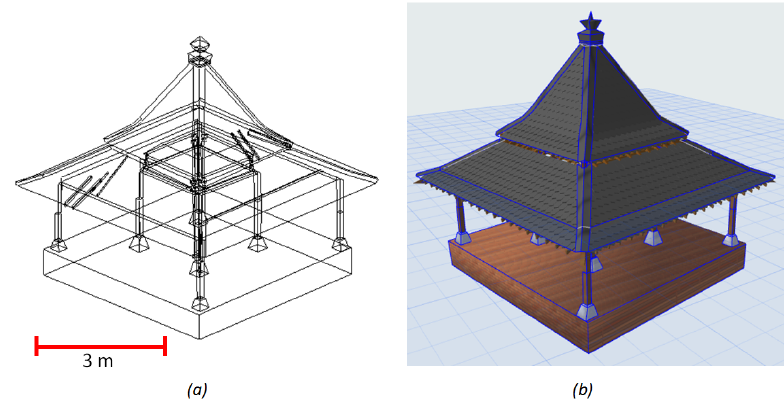
Figure 12. 3D models of the Central Pavilion in the BIM environment in ( a ) wireframe and ( b ) solid models.